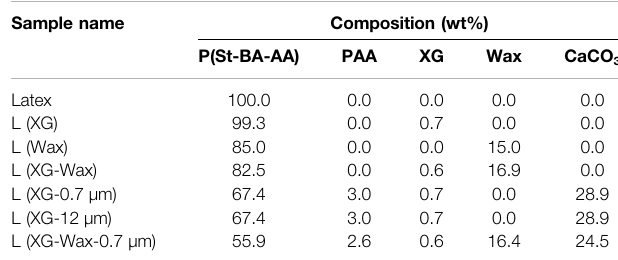
TABLE 2 | Sample nomenclature and percentage weight of each component for dry